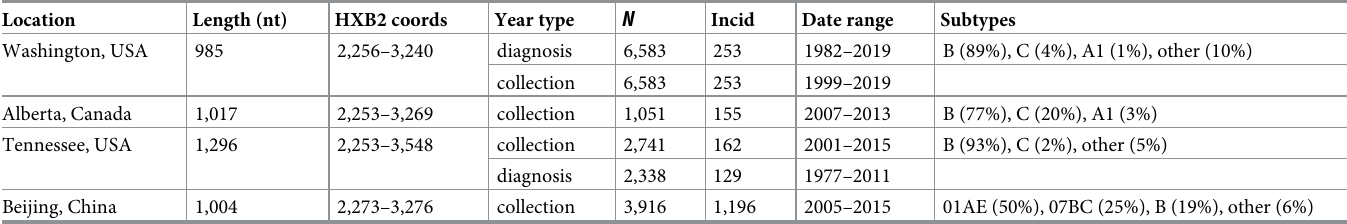
Table 1. Summary of sequence data characteristics. Length is the median length of nucleotide (nt) sequences. HXB2 coords = reference nucleotide coordinates in the HXB2 genome (Genbank accession K03455). Year type: sequences are annotated with year of sample collection, and in some cases date of HIV diagnosis. N = Total sample size, including both old and new sequences. Incid = number of sequences in ‘incident’ subset (most recent year). Subtype classifications were derived from the original data sources, when available, or generated de novo with SCUEAL